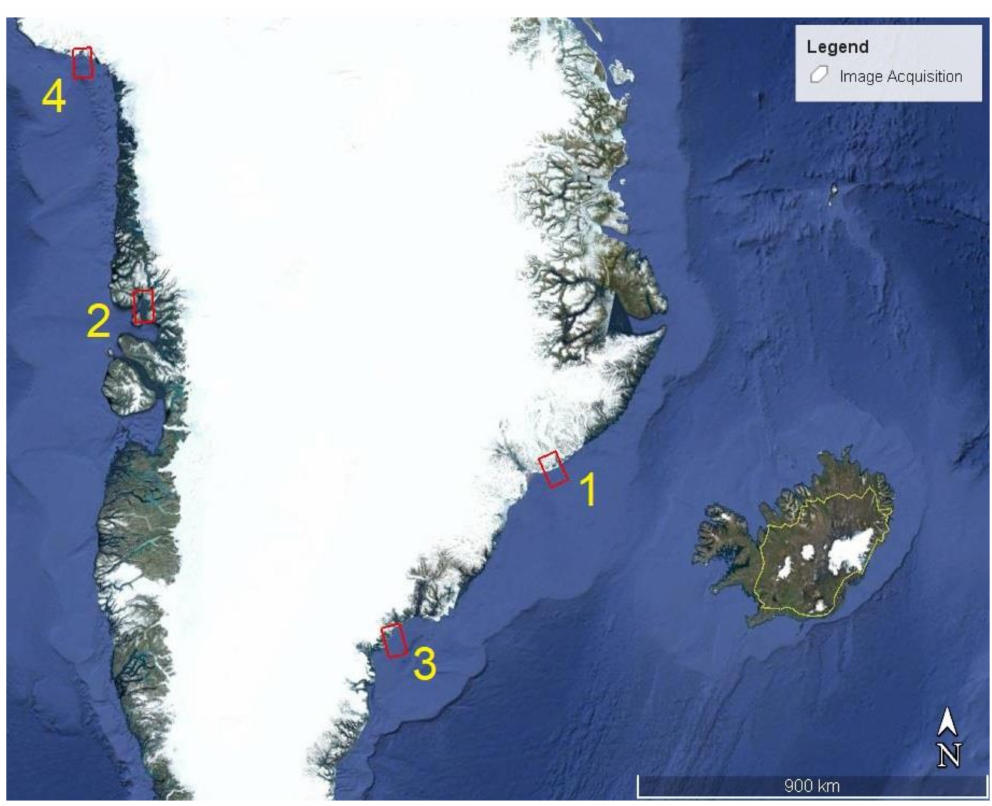
Figure 1. Google Earth image of data acquisition. Red boxes indicate the image footprints. Yellow numbers correspond to the image IDs in Table 1. Compass point indicates north. Scale: 900 m. Reprinted with permission from ref. [22] Copyright 2020 Remote